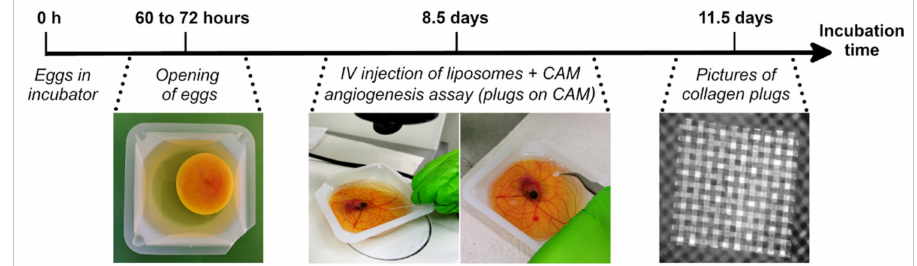
Figure 1. Timeline of the ex ovo chorioallantoic membrane (CAM) angiogenesis assay. At 60 to 72 h of incubation, embryos were removed from their shell and transferred to square weighing boats. At Day 8.5, liposomes containing clodronate or phosphate-buffered saline (PBS) were injected intravenously in the CAM, followed immediately by placement of collagen/mesh onplants on the CAM. After an additional 3 days of incubation, images were taken of the collagen plugs. The embryos were incubated at 37.8 ◦ C and 80% relative humidity, and the cover of a square Petri dish (SIMPD210-16, VWR International, Leuven, Belgium) was used as a